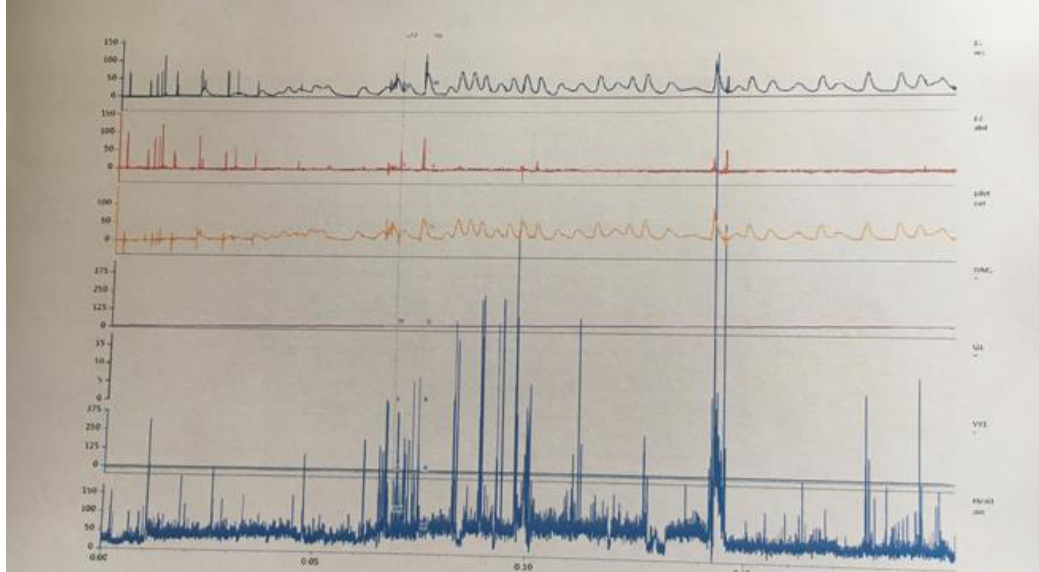
Figure 4. Urodynamic examination: unstable detrusor with hyper-reflexia. High-pressure bladder, bladder capacity correlated with age (80 ml). Leak Point Pressure at 25 ml volume: Pdet/Pves to 48 cm H 2 O, at 38 ml volume: Pdet/Pves to 60 cm H 2 O.